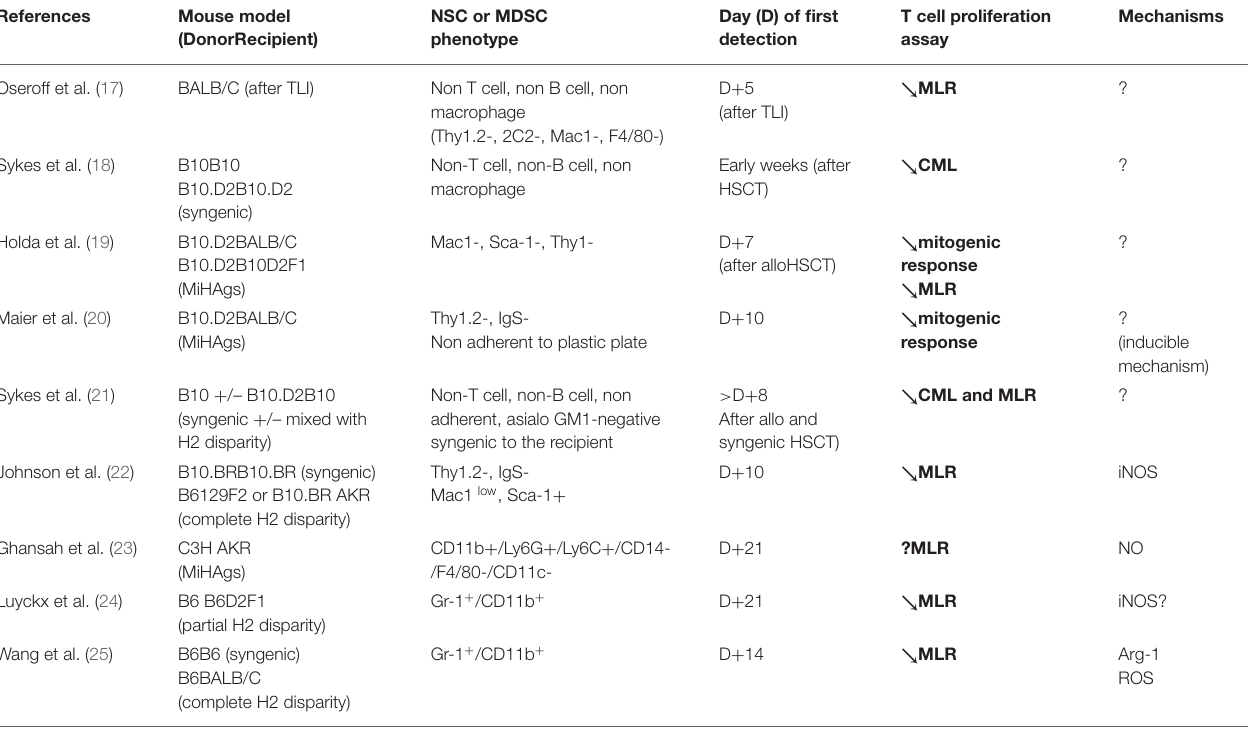
TABLE 1 | MDSC subsets and their immune suppressive mechanisms observed after conditioning regimen (irradiation) and after HSCT (allogenic or syngenic) in